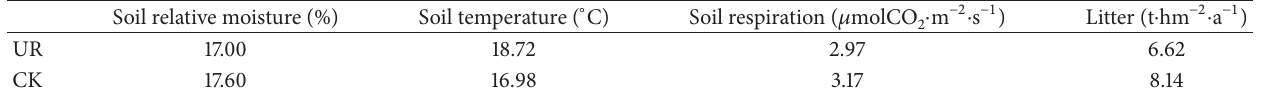
Table 2: Characteristics of the two